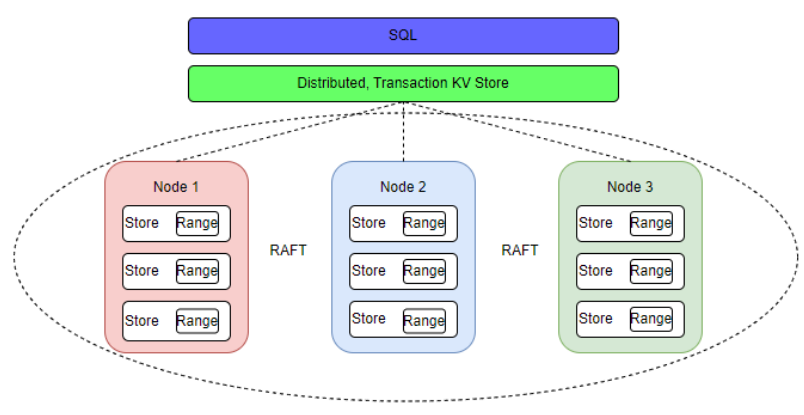
Figure 1. CockroachDB architecture diagram.